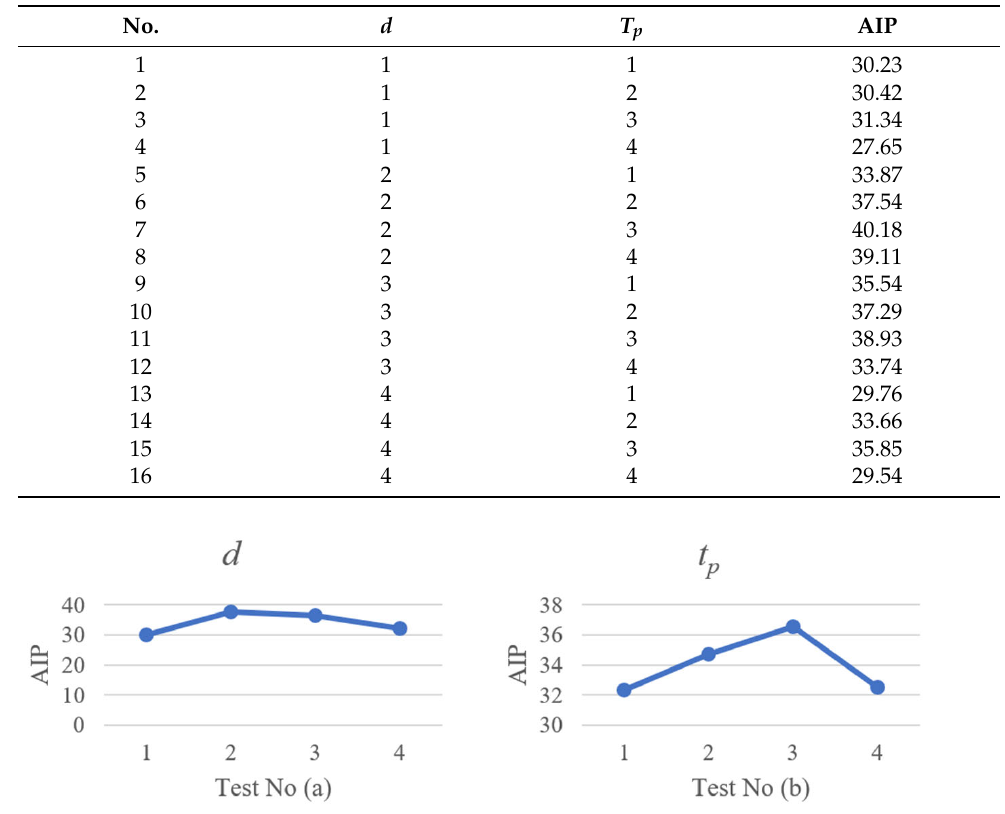
Figure 9. Effect of parameter settings on algorithm performance. (( a ) is the orthogonal test result for d , ( b ) is the orthogonal test result for t p )